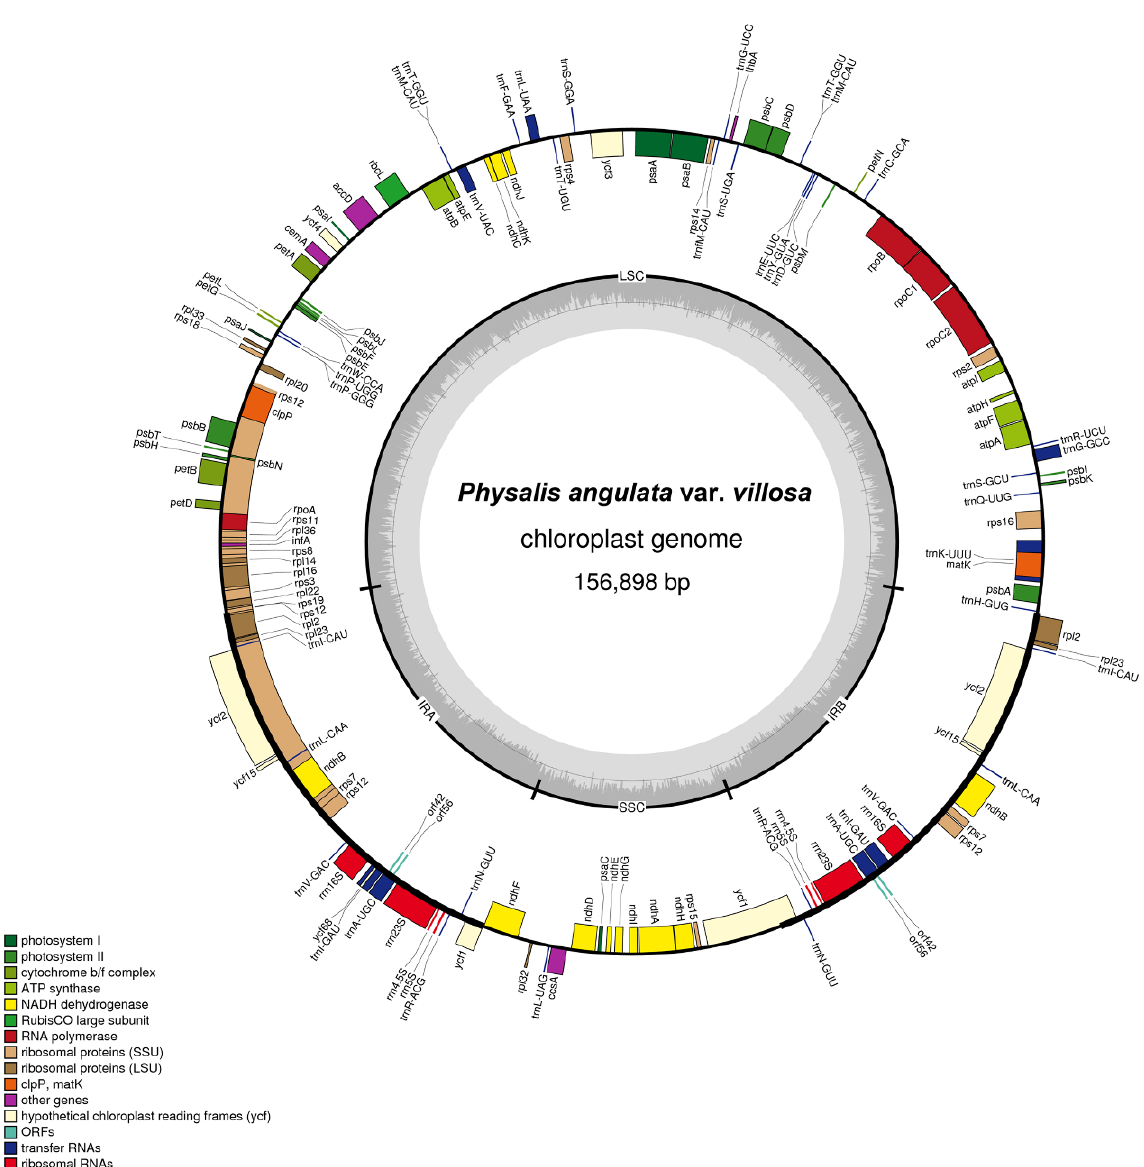
Figure 2. Gene map of the plastome of P. angulata var. villosa . Genes outside the circles are tran- scribed in a counterclockwise direction, and genes inside the circles in a clockwise direction. Known functional genes are color coded. AT and GC contents are denoted by the light and dark grays in the inner circle, respectively. LSC indicates large single-copy region and SSC indicates small single-copy region, whereas IRA and IRB indicate inverted repeats. Table 1. Summaries of complete plastome of P. angulata var. villosa.